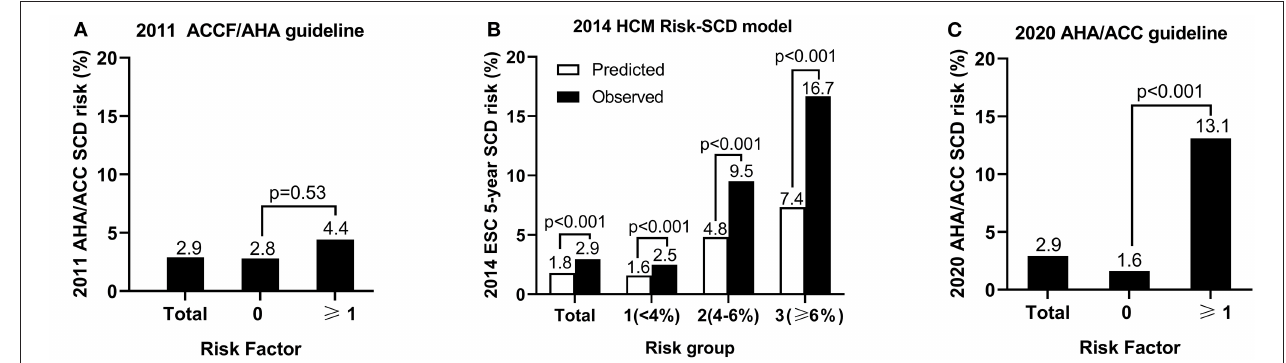
FIGURE 1 | The sudden cardiac death (SCD) risk of groups based on the risk stratifications in the 2011 ACCF/AHA guideline (A) , the 2014 ESC guideline (B) , and the 2020 AHA/ACC guideline (C) .